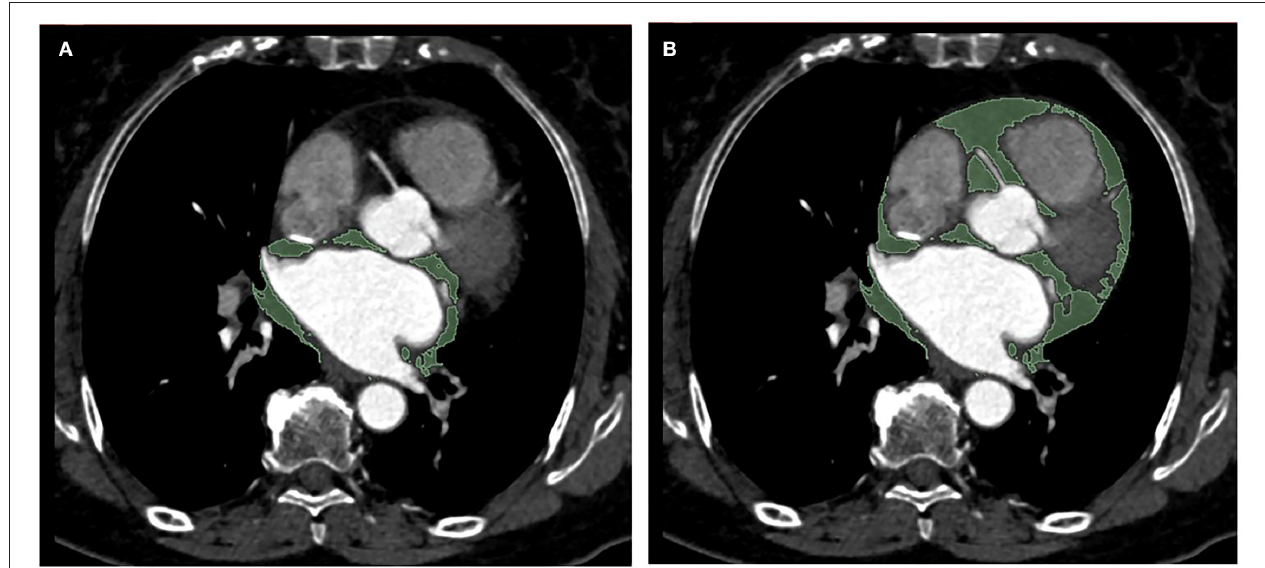
FIGURE 1 | Representative example of periatrial EAT (A) and total EAT (B) measurement in a single axial CT image in a patient (area in green depict traced EAT). EAT, epicardial adipose